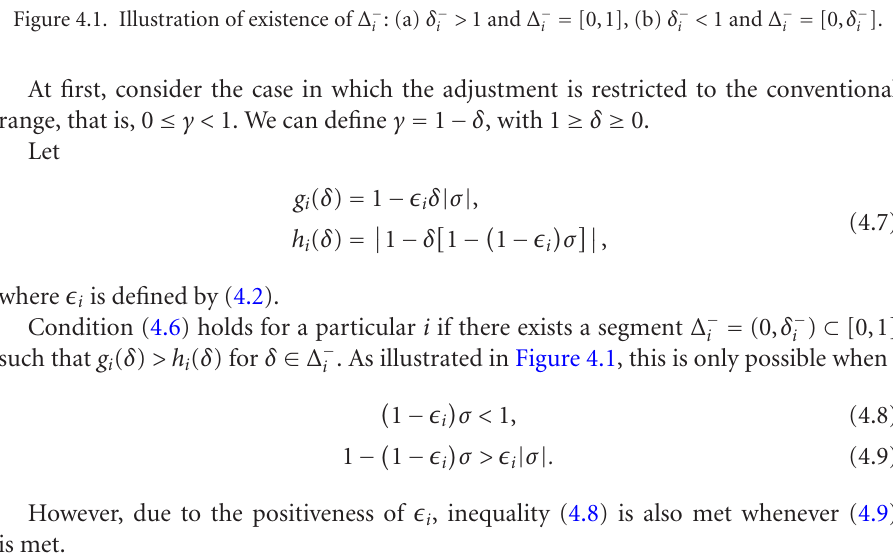
Figure 4.1. Illustration of existence of ∆ −